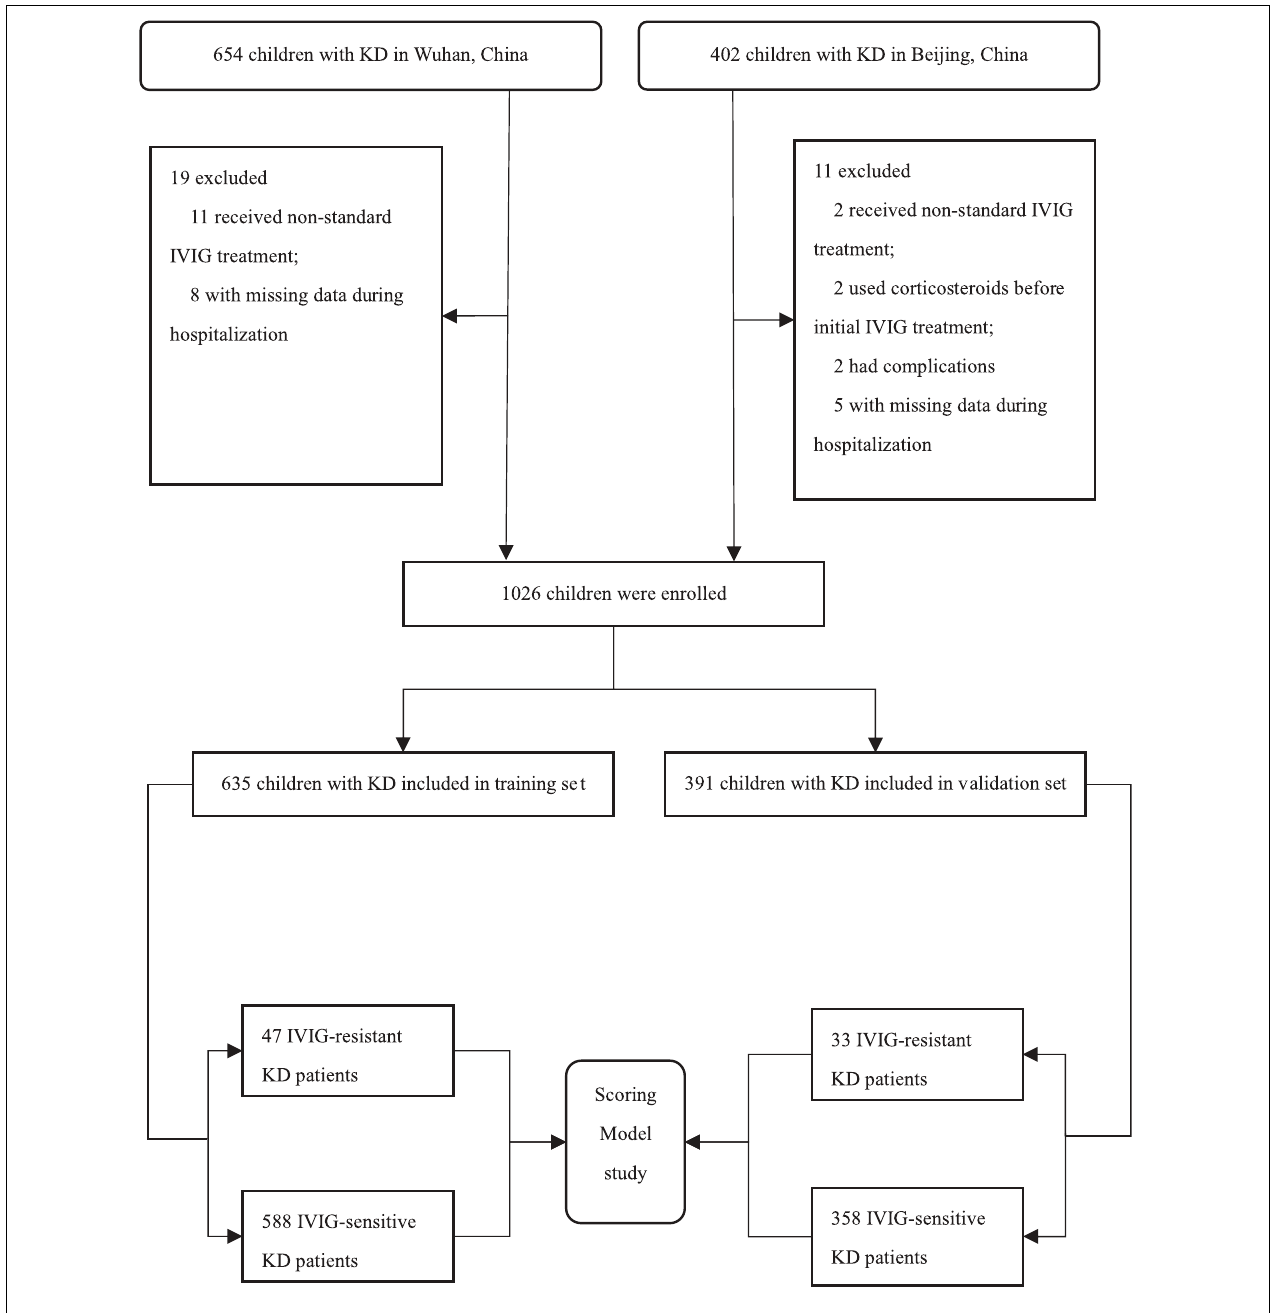
FIGURE 1 | Flow chart of study subject inclusion. IVIG, intravenous immunoglobulin; KD, Kawasaki disease.